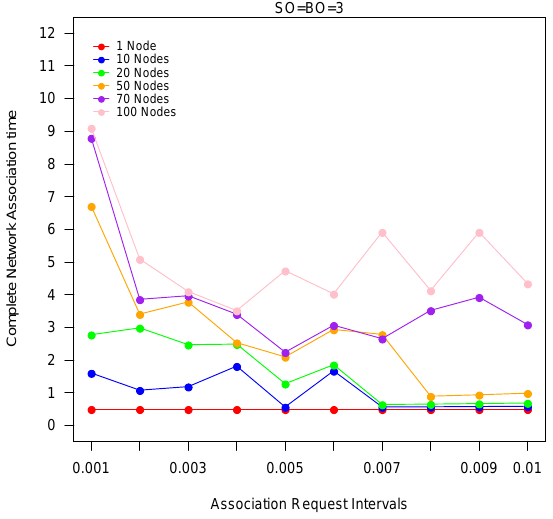
Figure 10. Full network association time (interval 0.01–0.1 s).